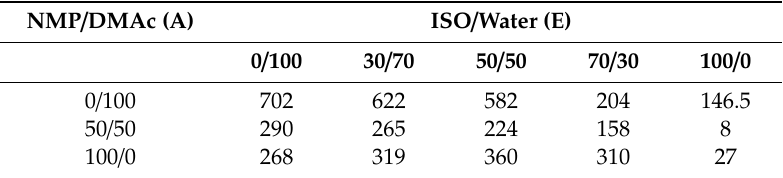
Table 3. Two-way analysis of variance (ANOVA): Flux versus solvent ratio (A) and the nonsolvent ratio (E).